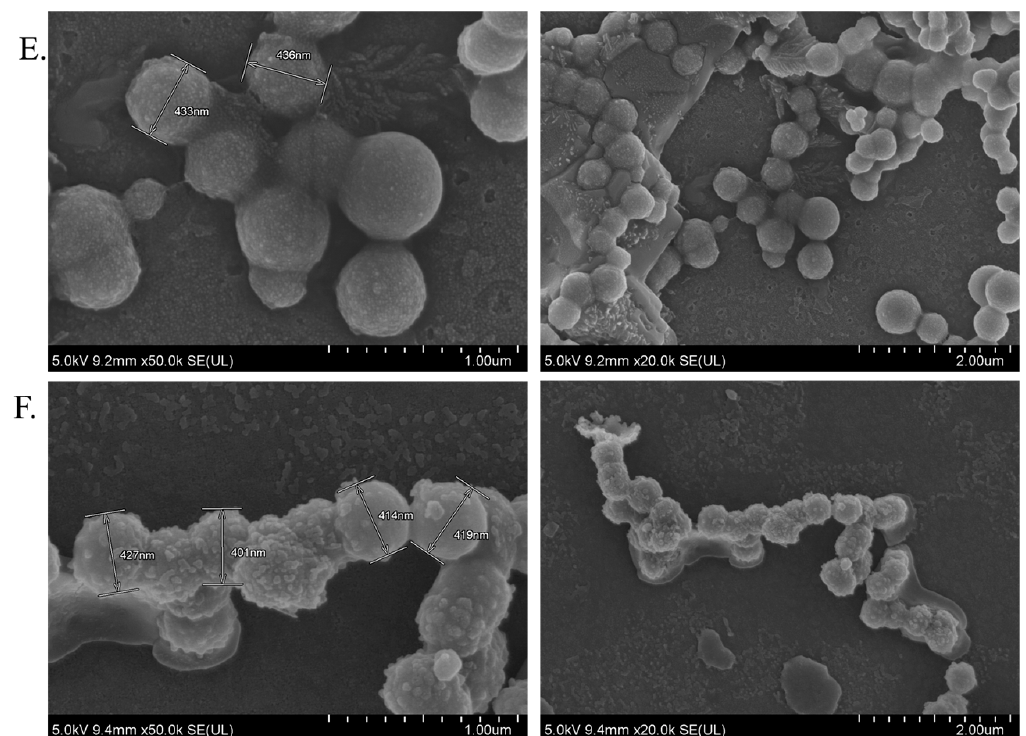
Figure 9. Morphology analysis of drug-loaded CA and α -KAMCA NPs by field emission (FE)-SEM: ( A ) CYP-loaded CA NPs; ( B ) DOX-loaded CA NPs; ( C ) CYP-loaded α -KAMCA NPs; ( D ) DOX-loaded α -KAMCA NPs; ( E ) CYP-loaded CMCA NPs; ( F ) DOX-loaded CMCA NPs.